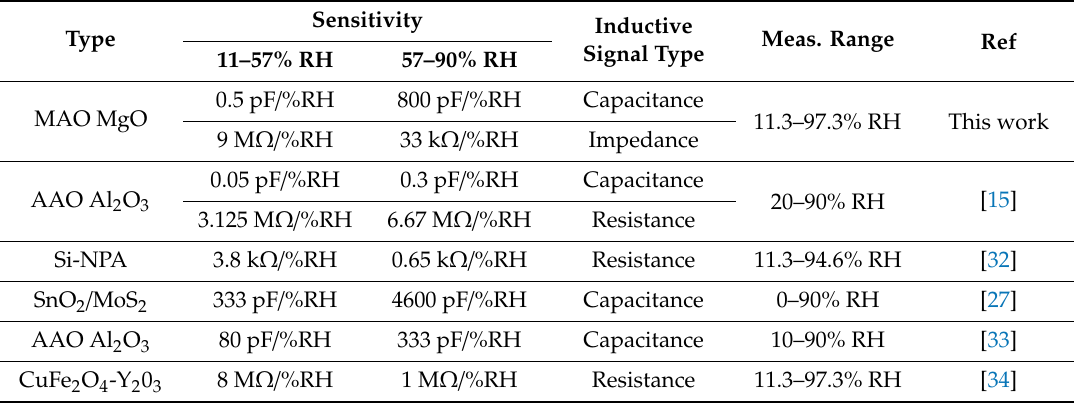
Table 3. Comparison in sensing properties towards various humidity